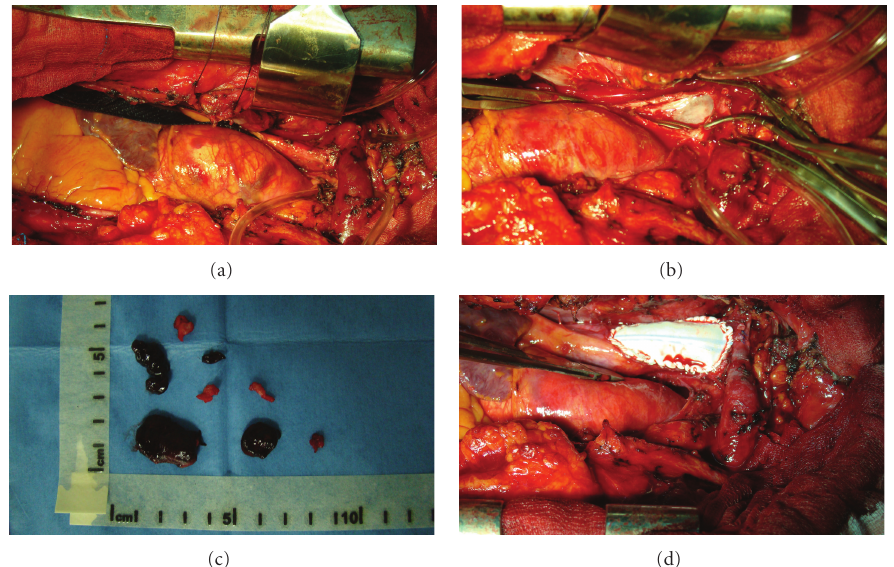
Figure 2: Surical findings. (a) The venous brachiocephalic trunk appeared enlarged. (b) The SVC and brachiocephalic vein were clamped. Their junction is opened, and thrombectomy performed. (c) A collection of samples of thrombus. (d) Venous repair using an enlargement patch of